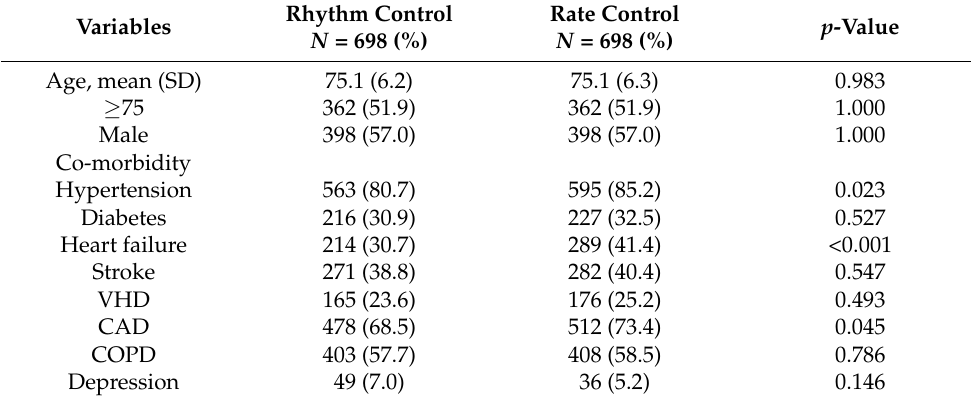
Table 5. Baseline characteristics of the matched